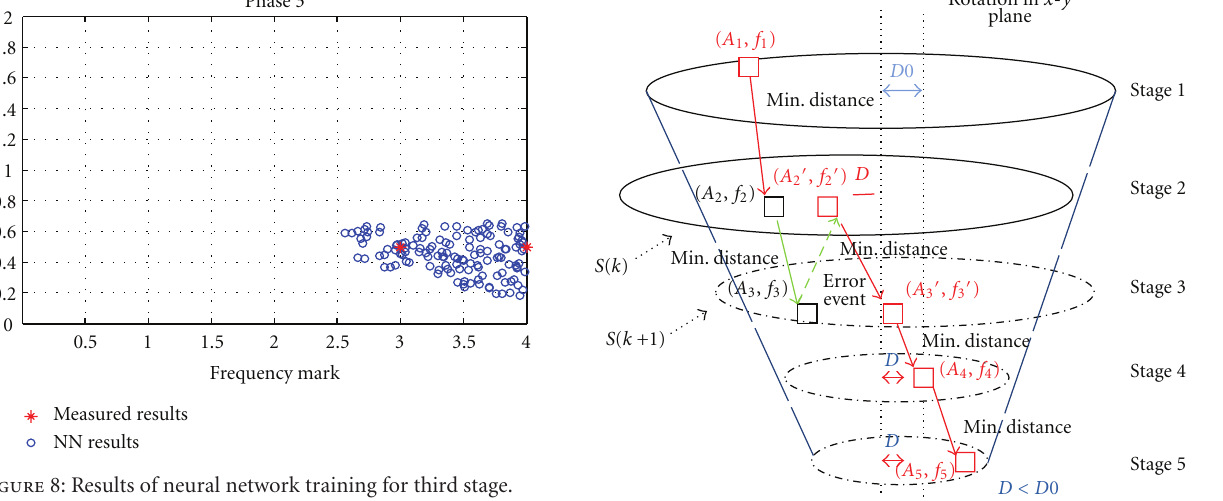
Figure 10: Optimal search strategy between states in jamming case.